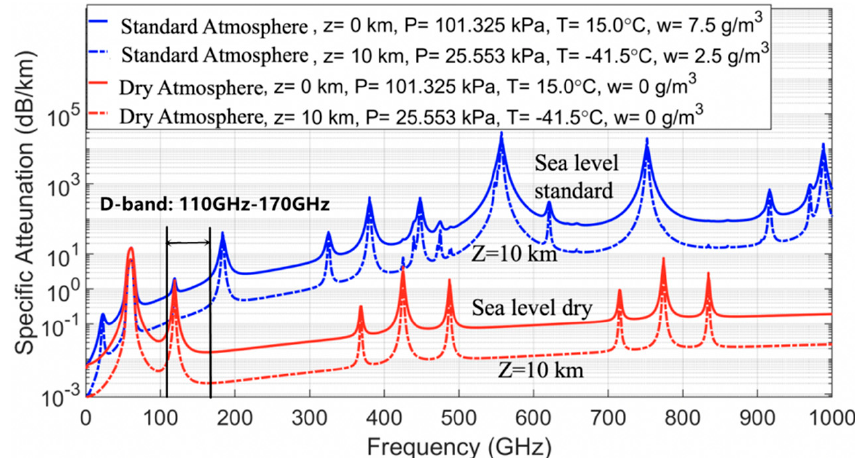
Figure 1. Free-space path atmospheric absorption for dry and standard environments at z = 0 km and z = 10 km.